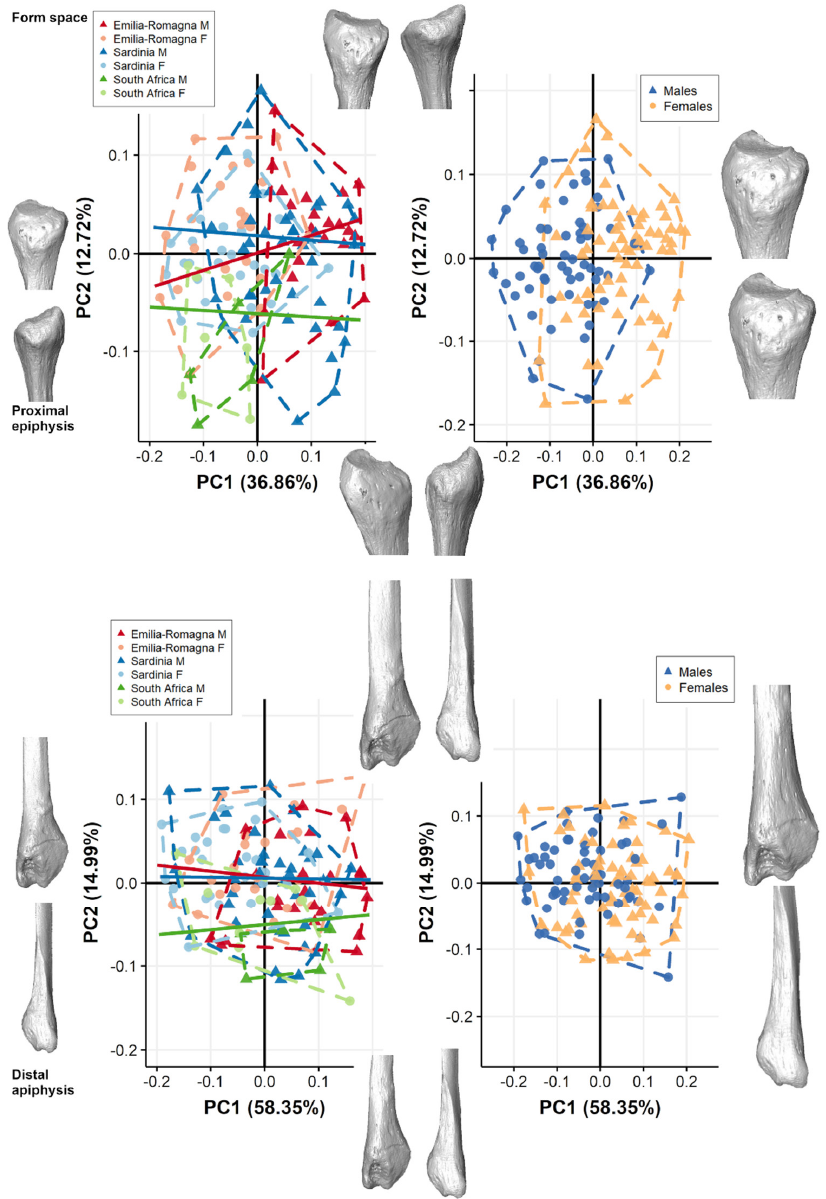
Figure 3. Scatterplot of form-space PC scores for both proximal and distal epiphyses computed considering all populations pooled together, grouped by population (on the left ) and by sex (on the right ). For both proximal and distal extremities, positive and negative extreme form variations along PC1 ( right and left ) and PC2 ( top and bottom ) are represented. Lines represent allometric trajectories for all populations. Allometric trajectories for ER (red), SAR (blue), and SA (green) are represented. For both extremities, CS is significantly different between pooled males and females (proximal epiphysis: ANOVA; F-value = 89.39, p < 0.001; distal epiphysis: ANOVA; F- value = 7.38, p < 0.001) (Figure 4).